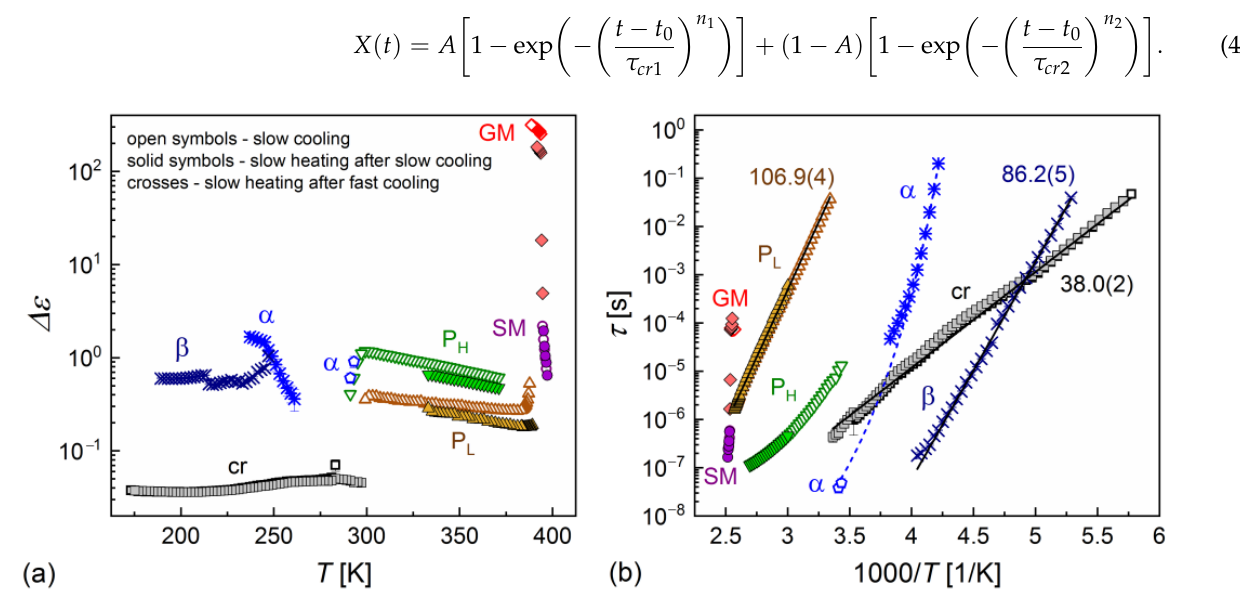
Figure 5. Dielectric strength of the relaxation processes in the smectic and crystal phases of 7HH6 ( a ) and the Arrhenius plot of the relaxation times ( b ). SM—soft mode in SmA*, GM—Goldstone mode in SmC*, P L —in-phase phason in SmC A *, P H —anti-phase phason in SmC A *, cr—relaxation process in a crystal phase, α — α -process in supercooled SmC A * and SmX A *, β — β -process in vitrified SmX A *. The activation energies in ( b ) are given in kJ/mol.